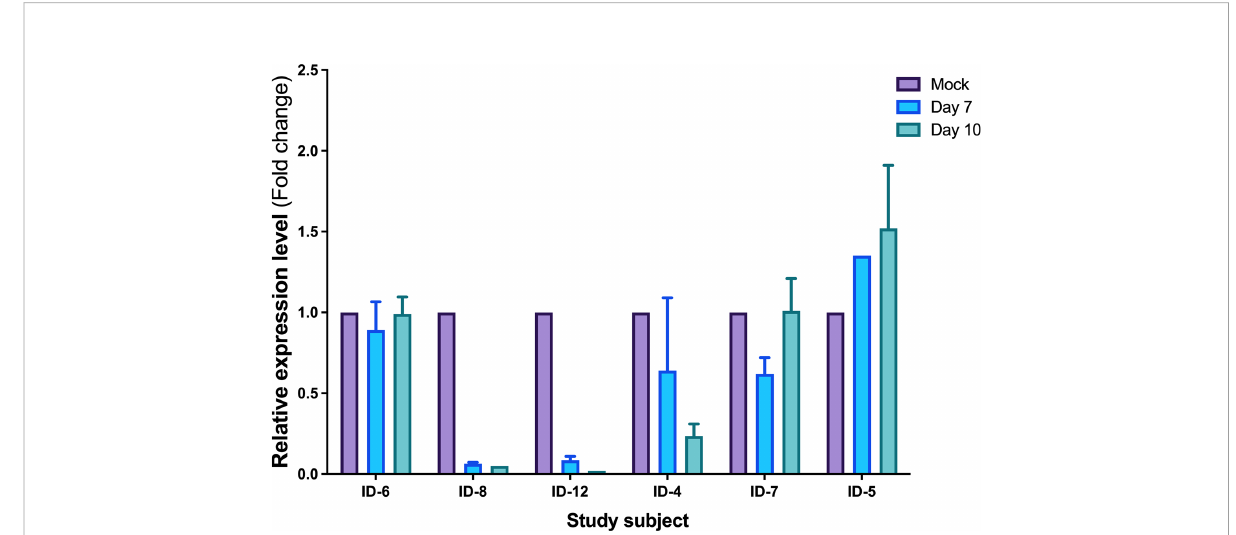
FIGURE 3 Expression levels of miR-10a-5p measured by qRT-PCR after modulation. Data are the mean ± SEM and are expressed as fold change using 5S levels as the reference (2 − DD Ct). Purple histograms represent the mean of expression values from 5S, blue histograms represent the mean of expression values from day 7 and green from day 10. Expression values are normalized to the value of the control condition. Error bars represent the standard error of the mean of the three relative expressions from three biological replicates and two technical duplicates of each